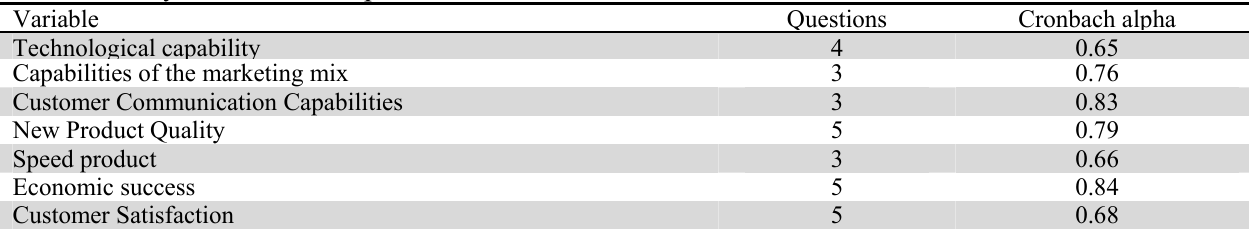
The summary of Cronbach alpha